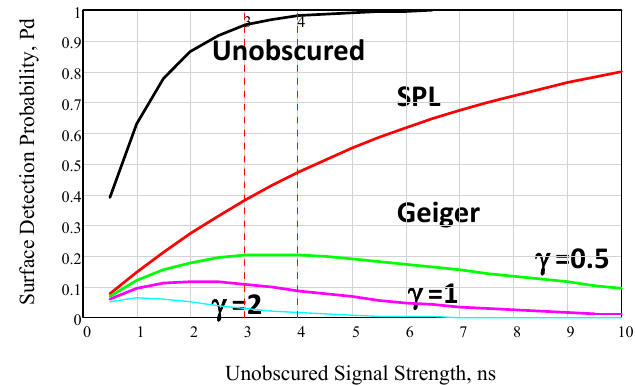
Figure 16. Surface detection probabilities for SPL and Geiger Mode (GM) lidars as a function of the unobscured signal strength for a tree canopy having a one way transmission of 40%. Unlike the GM lidar which has an unobscured signal strength that optimizes the surface detection probability, the SPL lidar can “power” through the canopy by increasing the laser pulse energy.